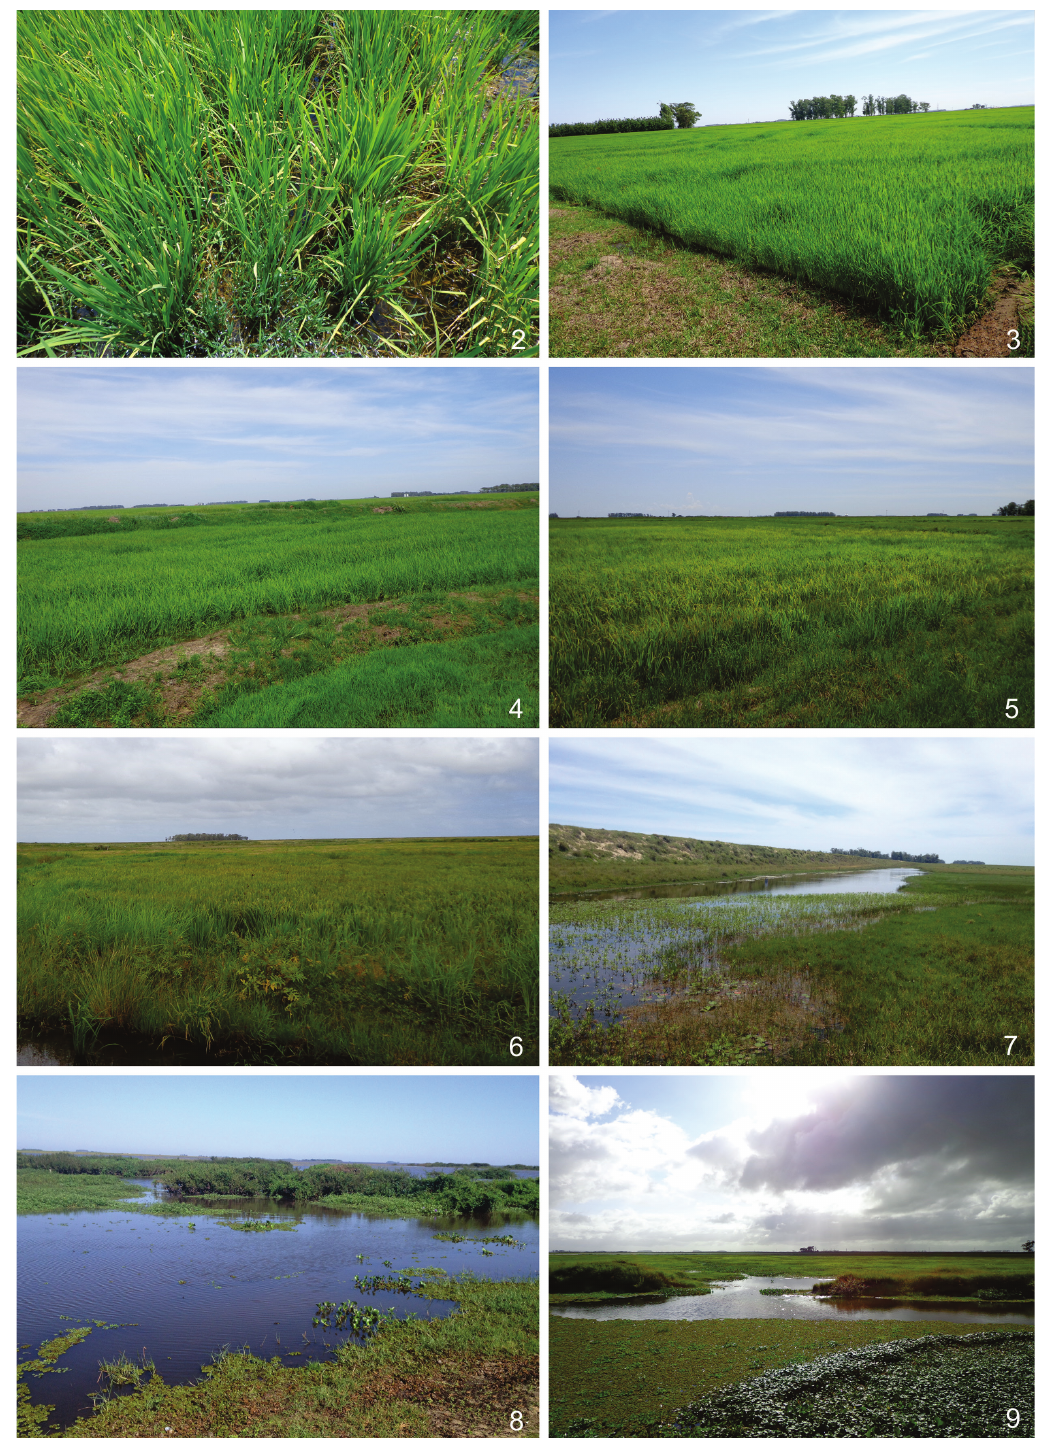
Figures 2–9. View of the study sites: (2) Detailed view of the rice-water samples, (3) Rice area 1 – R1, (4) Rice area 2 – R2, (5) Rice area 3 – R3, (6) Rice area 4 – R4, (7) Lake 1 – L1, (8) Lake 2 – L2, (9) Lake 3